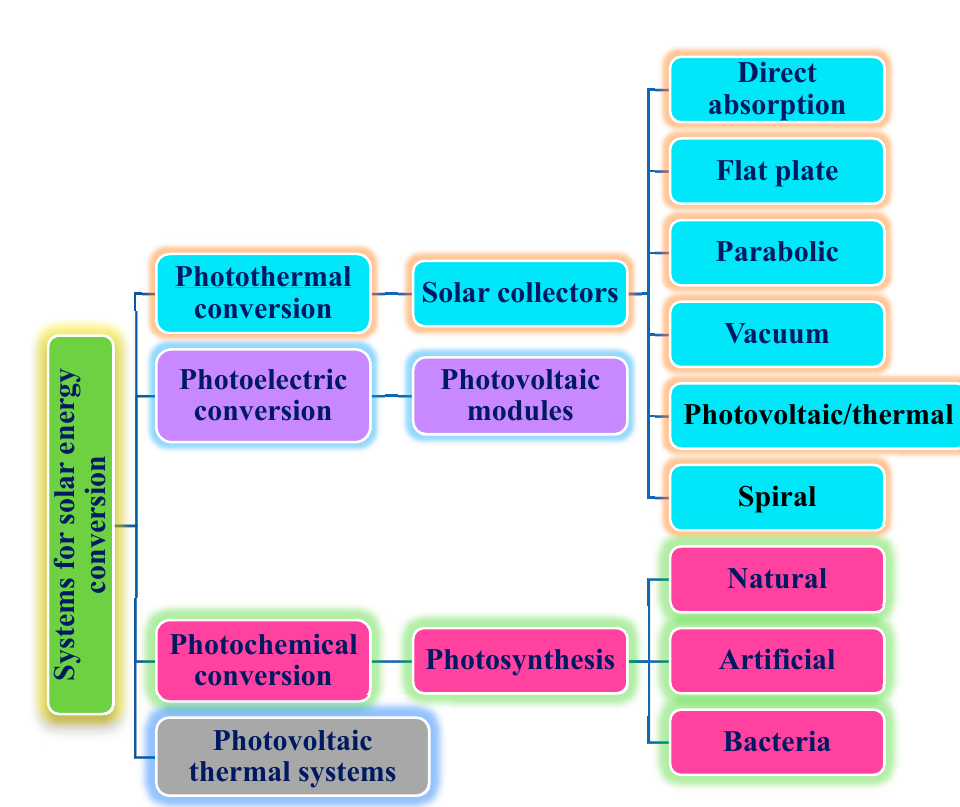
Figure 4. Description of solar energy conversion and systems.